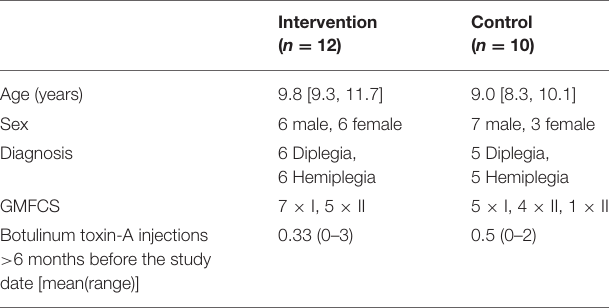
TABLE 1 | Characteristics of recruited